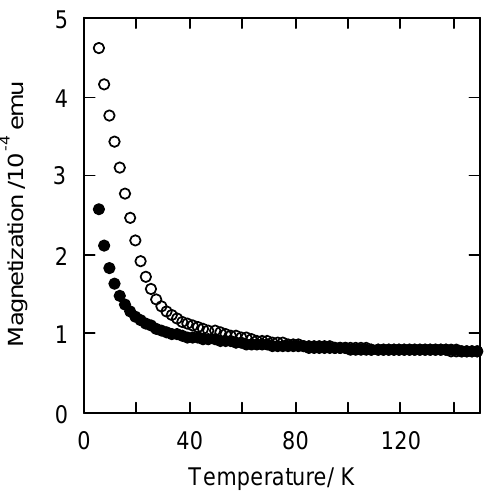
Figure 9. Temperature dependence of the magnetization before ( ● ) and after ( ○ ) irradiation (T = 10 K λ = 642 nm, P = 15 mW·cm − 2 ) of RbCoFe PBA/silica